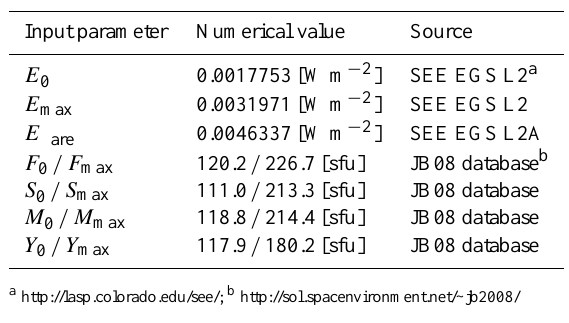
Table 2. Estimated pseudo solar indices to reproduce the peak EUV radiation during the X17.2 solar flare on 28 October 2003 using TIMED/SEE